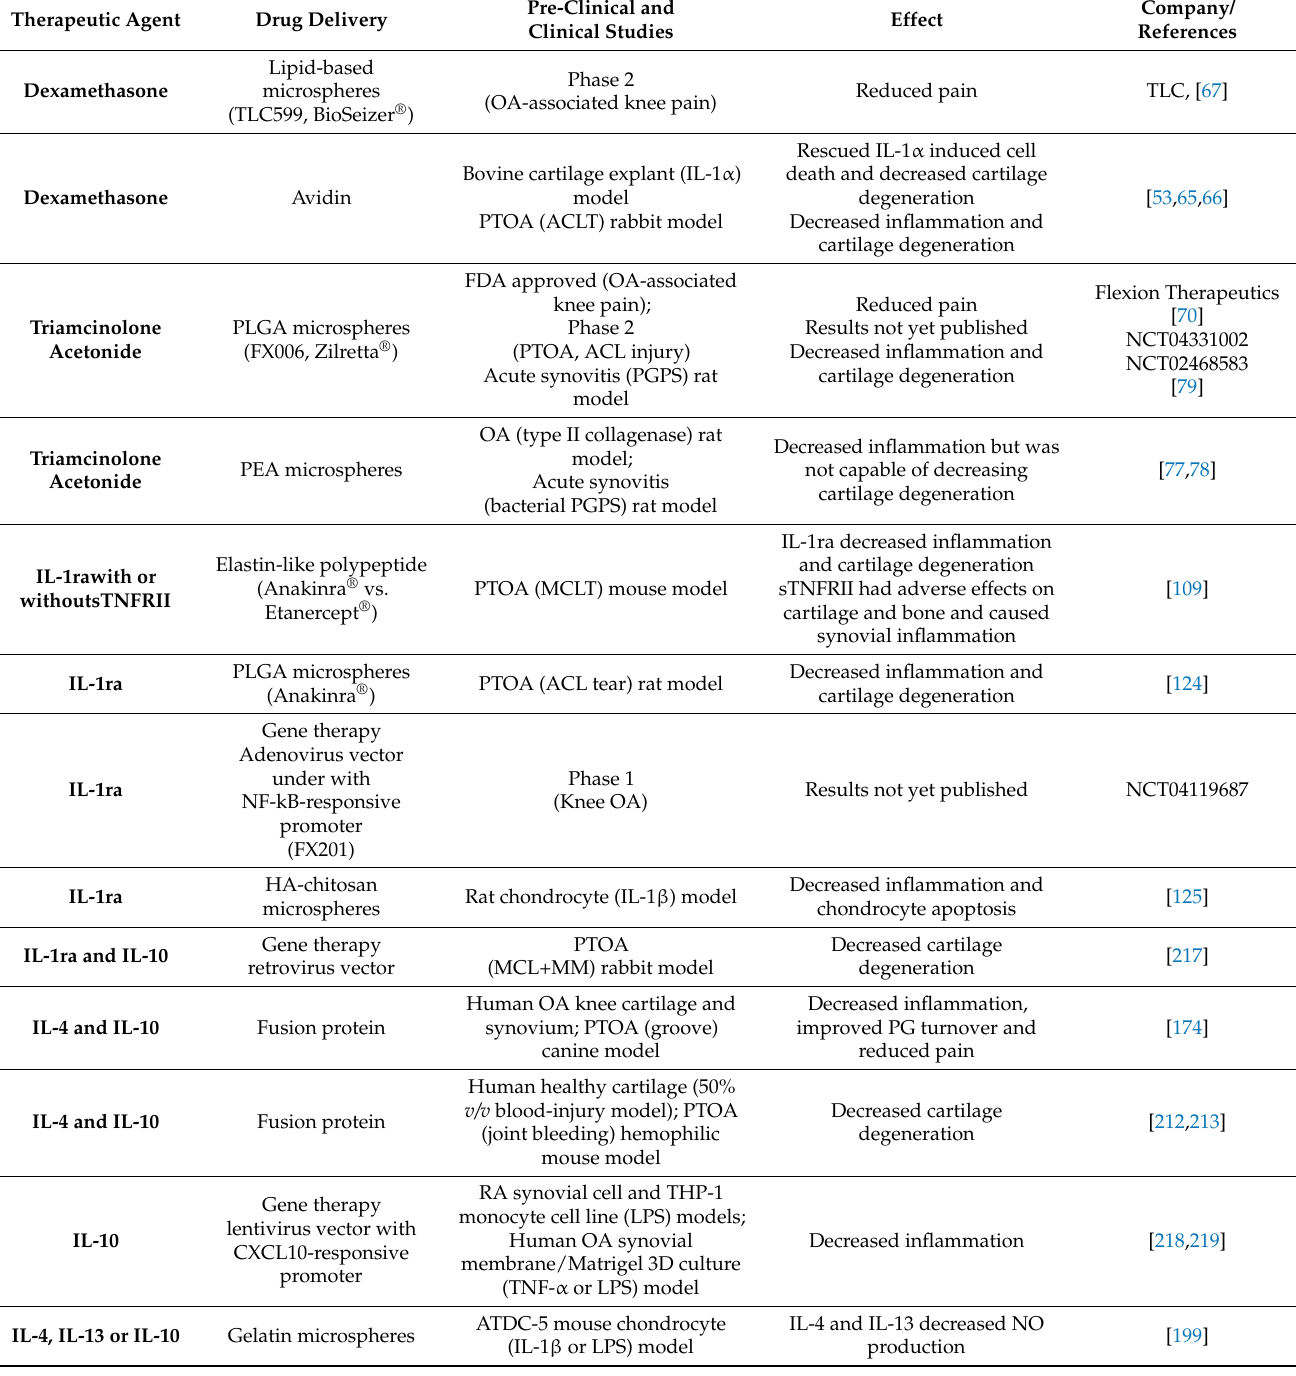
Table 2. Possible sustained delivery approaches in preventing or delaying knee PTOA. In order to extend the release and the sustainability of different therapeutic agents used to treat or delay PTOA progression, different delivery systems of synthetic or natural biomaterials were tested, whereas only PLGA microspheres Zilretta ® is approved by the FDA to treat OA-related knee pain. Abbreviations: ACL (anterior cruciate ligament), ACLT (anterior cruciate ligament transection), IL-4 (interleukin- 4), IL-10 (interleukin-10), IL-13 (interleukin-13), IL-1ra (interleukin-1 receptor antagonist), IL-1 α (interleukin-1 alpha), IL-1 β (interleukin-1 beta), MCL+MM (medial collateral ligament + medial meniscectomy), MCLT (medial collateral ligament transection), nuclear factor-kappa B (NF-kB), NO (nitric oxide), PG (proteoglycan), PGPS (peptidoglycan-polysaccharide (PGPS), PGLA (poly(lactic-co-glycolic acid), sTNFRII (soluble receptor for tumor necrosis factor type